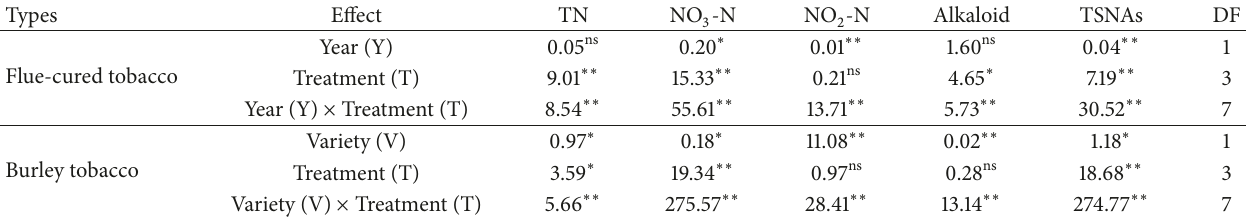
Table 2: ANOVA comparison of the effects of regulatory treatments, year, and tobacco variety and their interactions on TN, NO 3 -N, NO 2 -N, alkaloid, and TSNA concentrations in tobacco.